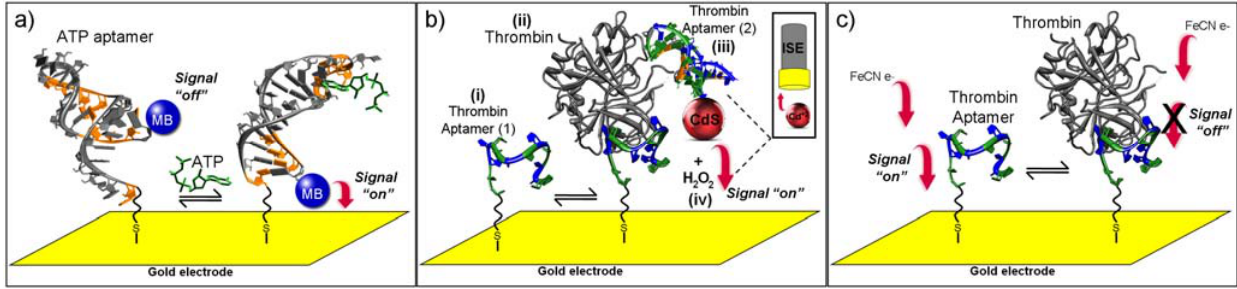
(PDB: 1QDF) is immobilized on gold surface as in (b) and the interaction between aptamer and thrombin (PDB: 1HAO) can be monitored by impedimetric measurements in the presence of